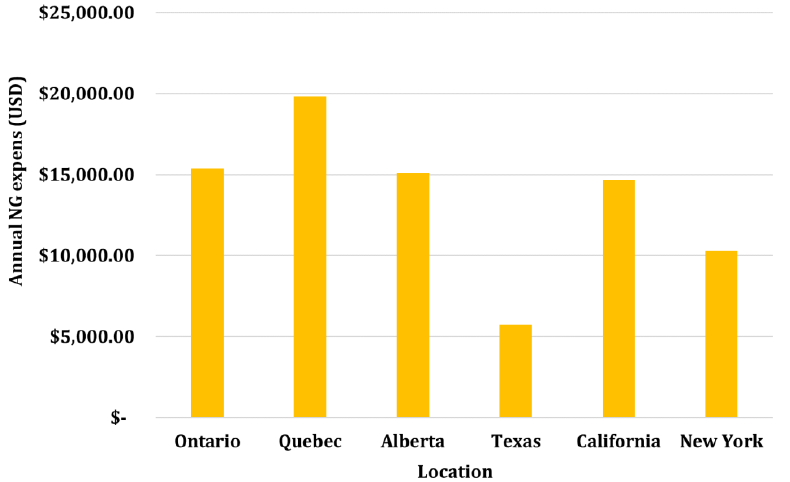
The annualized natural gas expense in each location for Greenhouse 2 is summarized